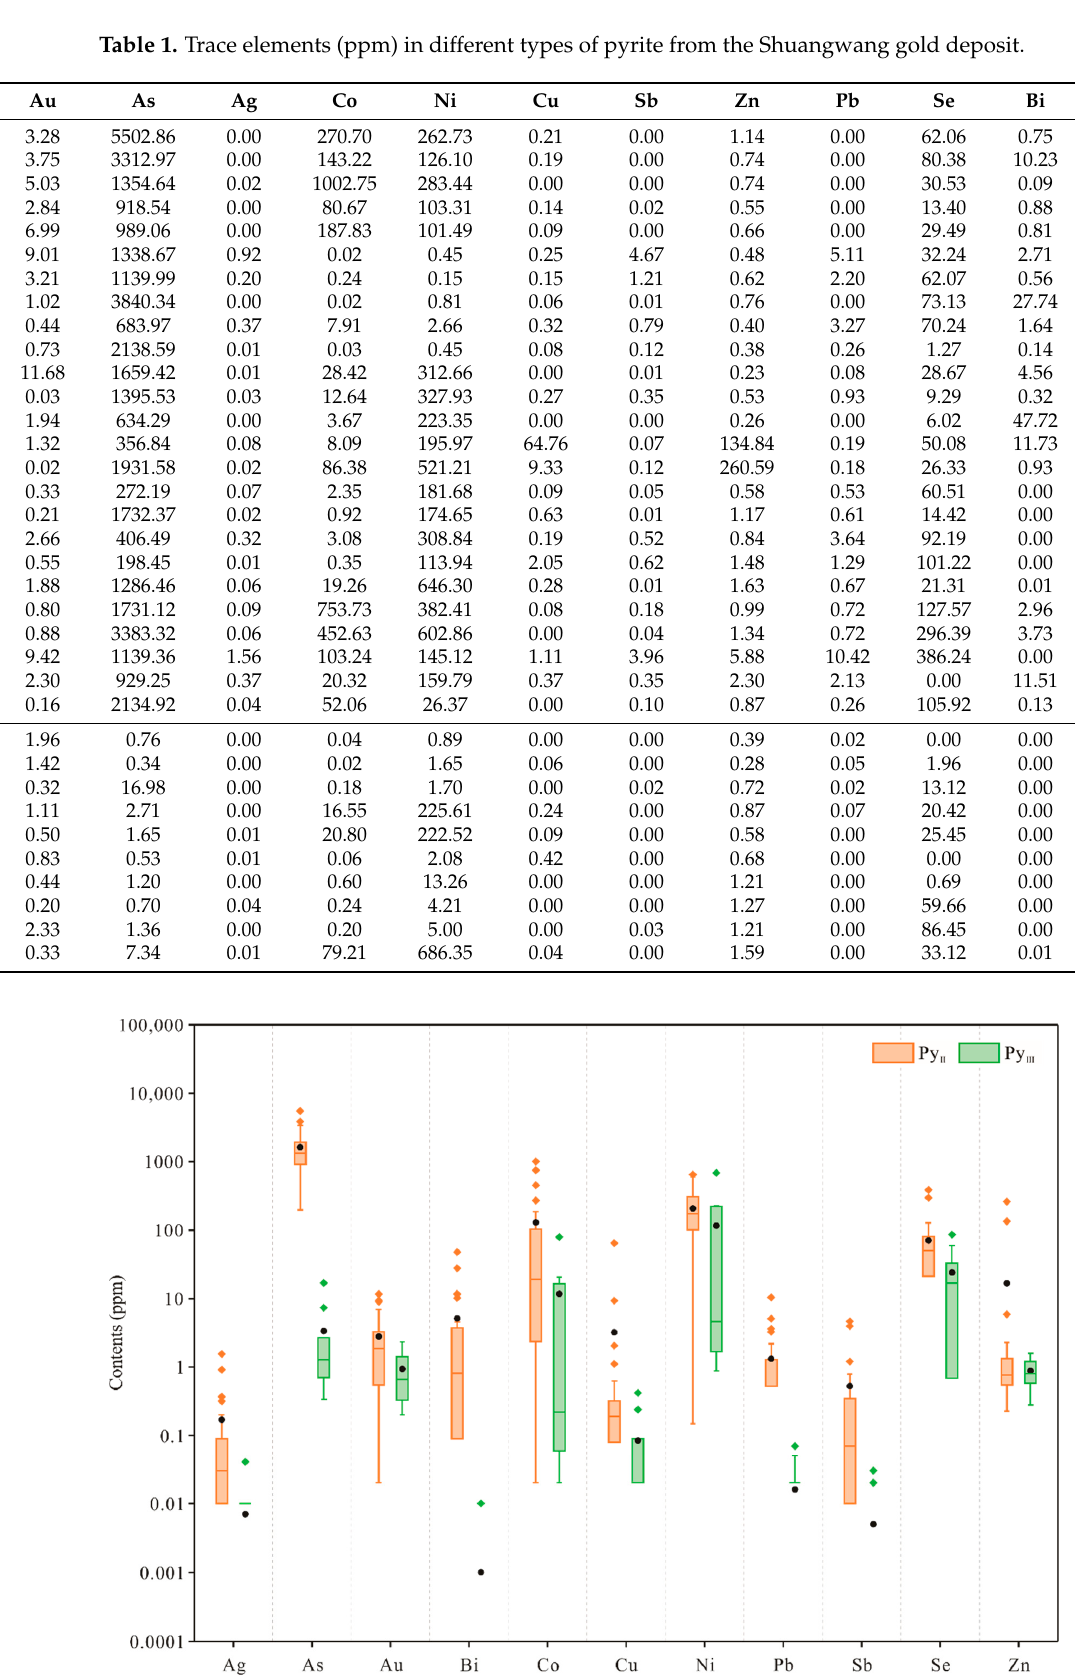
Figure 6. Box plot of trace element compositions for pyrite from Shuangwang deposit. Among the analyzed elements in Py ⅠⅠ , the elements had highly variable concentra- tions, ranging from 0.02 to 11.68 ppm for Au, 198.45 to 5502.86 ppm for As, 0.00 to 1.56 ppm for Ag, 0.02 to 1002.75 ppm for Co, 0.15 to 646.30 ppm for Ni, 0.00 to 64.76 ppm for Cu, 0.00 to 4.67 ppm for Sb, 0.23 to 260.59 ppm for Zn, 0.00 to 10.42 ppm for Pb, 0.00 to 386.24 ppm for Se, and 0.00 to 47.72 ppm for Bi. The elemental concentrations in Py ⅠⅠⅠ ranged from 0.20 to 2.33 ppm for Au, 0.34 to 16.98 ppm for As, 0.00 to 0.04 ppm for Ag, 0.02 to 79.21 ppm for Co, 0.89 to 686.35 ppm for Ni, 0.00 to 0.42 ppm for Cu, 0.00 to 0.03 ppm for Sb, 0.28 to 1.59 ppm for Zn, 0.00 to 0.07 ppm for Pb, 0.00 to 86.45 ppm for Se, and 0.00 to 0.01 ppm for Bi (see Table 1). 5.3. In Situ Sulfur Isotope The analysis results for the in situ sulfur isotopes are provided in Table 2. The δ 34 S V- CDT values of pyrite from the stage ⅠⅠ (Py ⅠⅠ ) varied from 11.1 to 15.2‰ (mean = 12.9‰, n = 7), while those in Py ⅠⅠⅠ varied from 11.1 to 13.5‰ (mean = 12.0‰, n = 3). Table 2. Summary of sulfur isotope results from the Shuangwang gold deposit. Sample No.